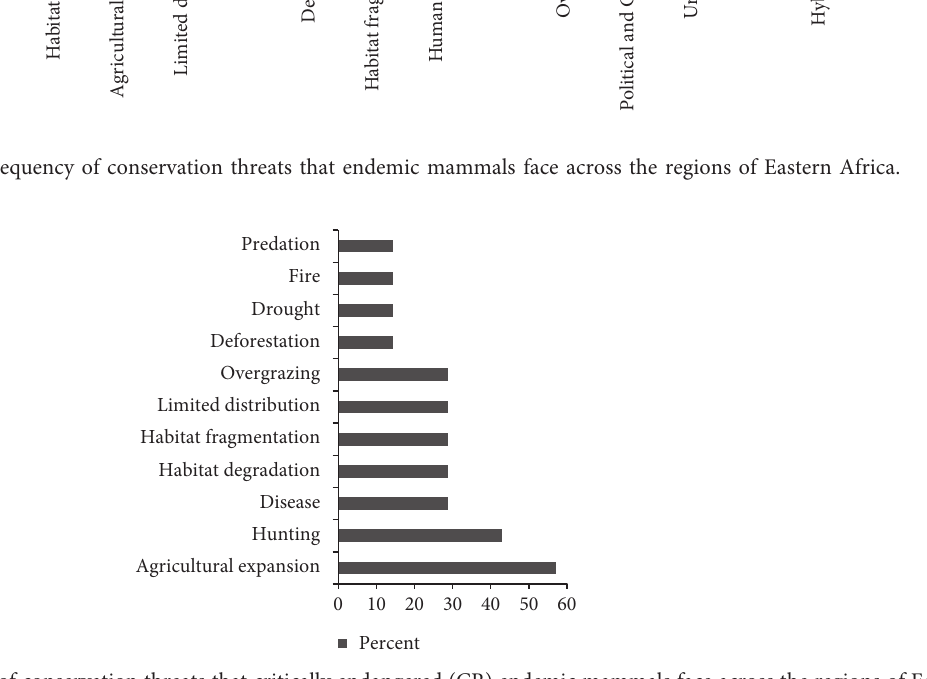
Figure 4: Ranked frequency of conservation threats that critically endangered (CR) endemic mammals face across the regions of Eastern